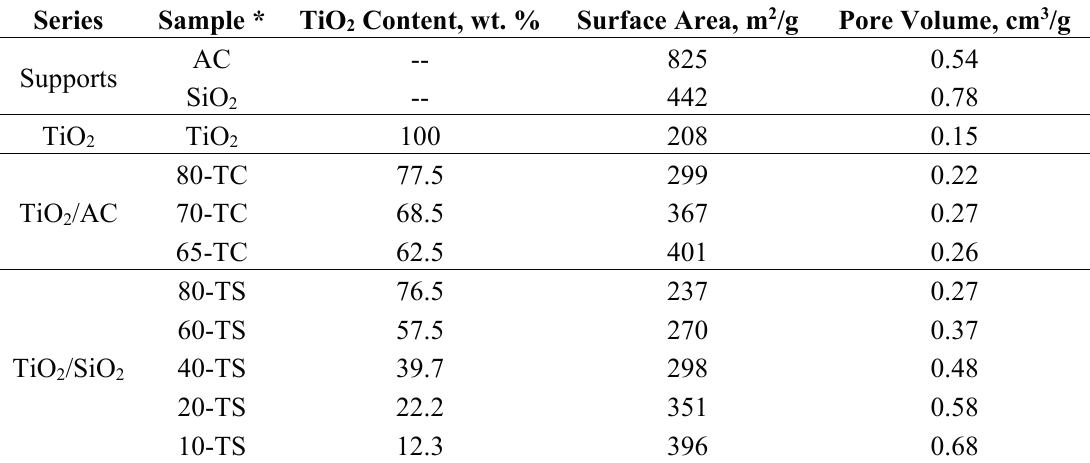
Table 1. TiO 2 content and textural properties of the